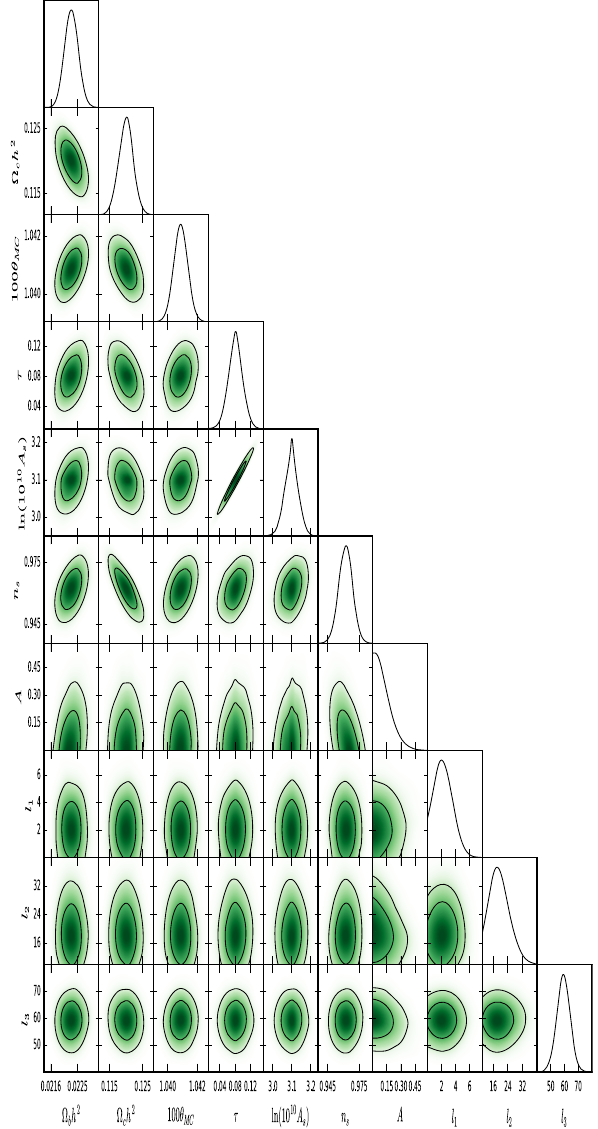
Fig. 3 Contours for the 68% and 95% confidence limits for the reso- nance parameters A ∗ = p 1 = q 1 = r 1 and multipoles (cid:2) ∗ = p 2 , q 2 , r 2 for the three dips in the CMB power spectrum